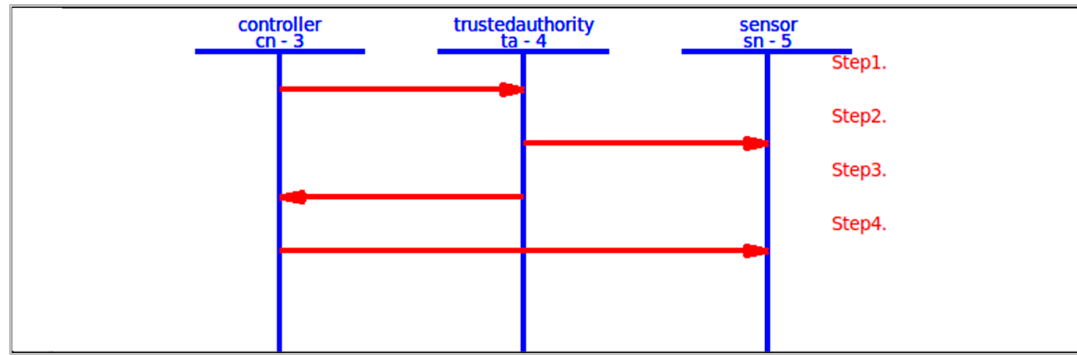
Figure 11. SPAN animator of protocol-II.